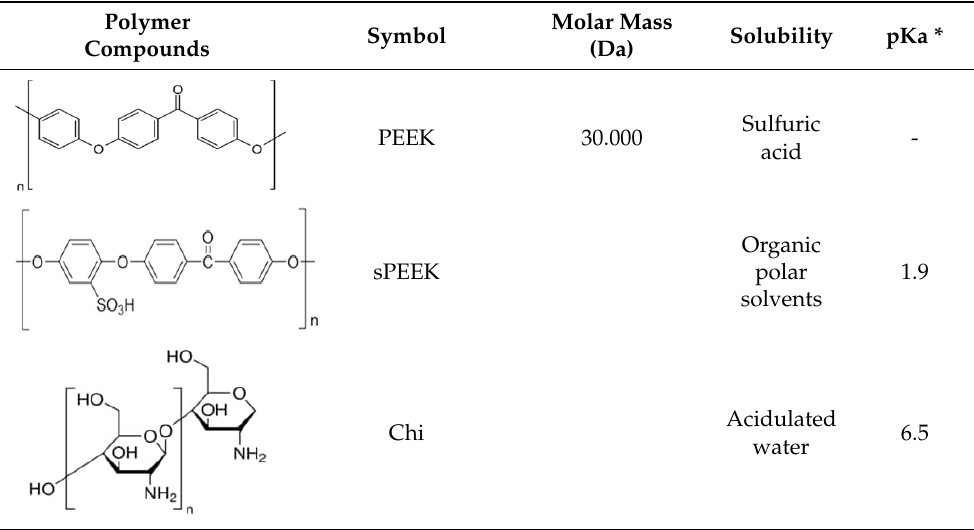
Table 1. The characteristics of the used polymeric and derivative compounds.